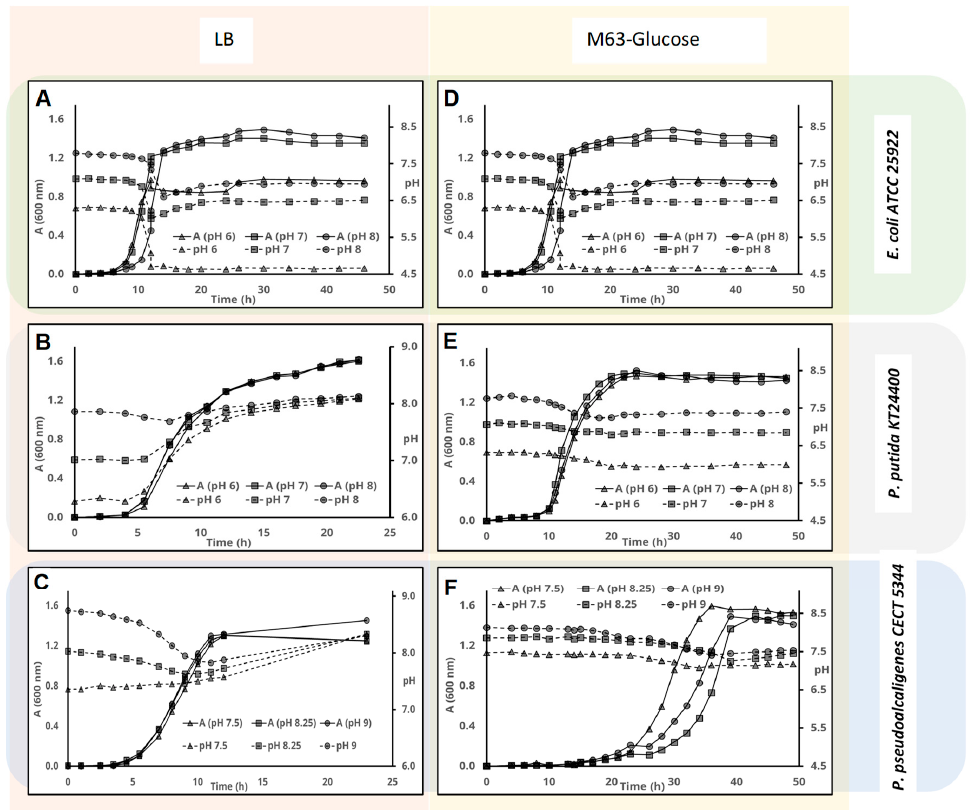
Figure 1. Influence of the initial pH on pH change in different bacterial strains. Cells were inoculated in either Luria-Bertani (LB) complex medium (panels ( A – C )) or defined minimal M63 medium with glucose as C-source (panels ( D – F )). The pH of the medium (discontinuous lines) and cell-growth (A 600 nm, continuous lines) were measured at the indicated times for E. coli ATCC 25,922 (panels ( A , D )), Pseudomonas putida KT2440 (panels ( B , E )), and Pseudomonas pseudoalcaligenes CECT 5344 (panels ( C , F )).